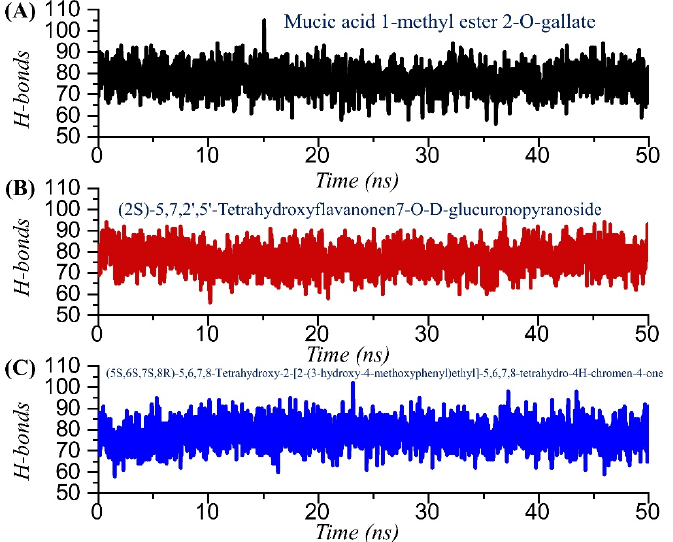
Figure 8. Hydrogen bonding analysis of the TCM42798, TCM47007, and TCM30675 complexes. ( A ) The H-bonds graph for mucic acid 1-methyl ester 2-O-gallate. ( B ) The H-bonds graph for TCM47007 or (2S)-5,7,2’,5’-Tetrahydroxyflavanone 7-O--D-glucuronopyranoside. ( C ) The H-bonds graph for TCM30675 or (5S,6S,7S,8R)-5,6,7,8-Tetrahydroxy-2-[2-(3-hydroxy-4-methoxyphenyl)ethyl]-5,6,7,8- tetrahydro-4H-chromen-4-1